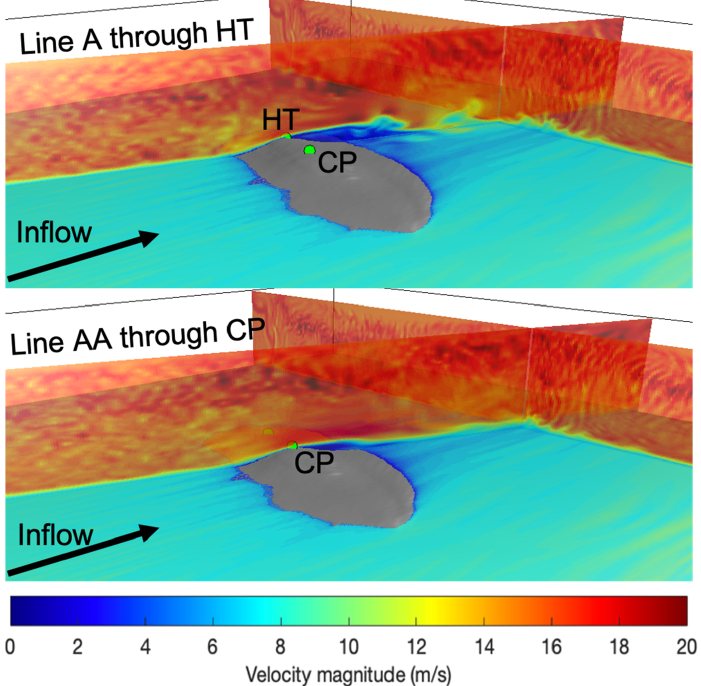
Figure 4. Turbulent structures in the vertical planes passing along line A through point HT ( upper ) and along line AA through point CP ( lower